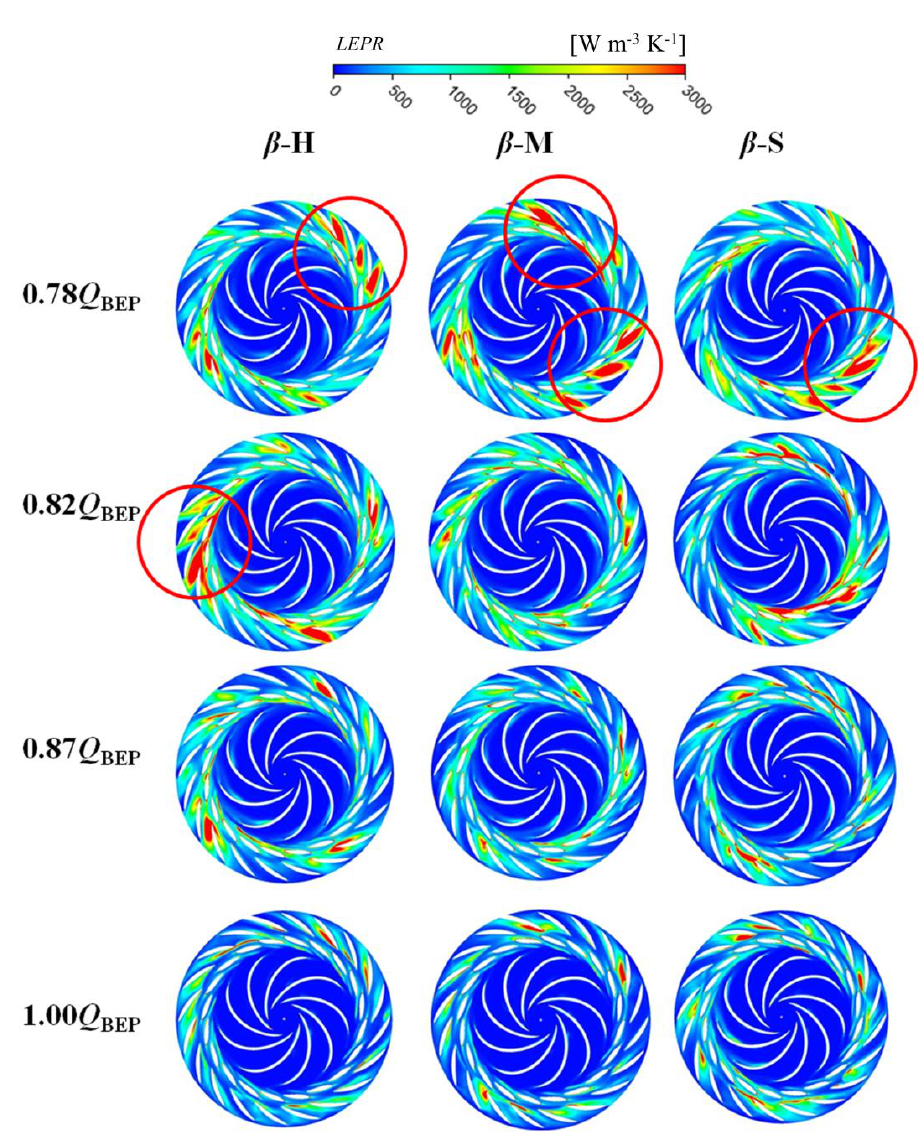
Figure 15. Comparison of hydraulic loss distribution in middle spanwise plane in discharge opera- tion points.